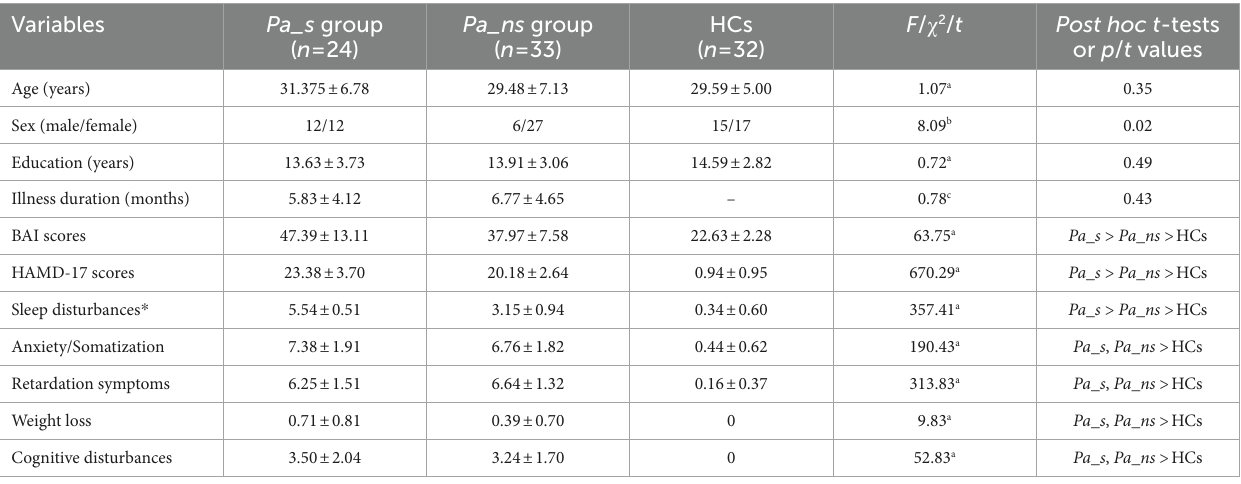
TABLE 1 Demographic and clinical characteristics of